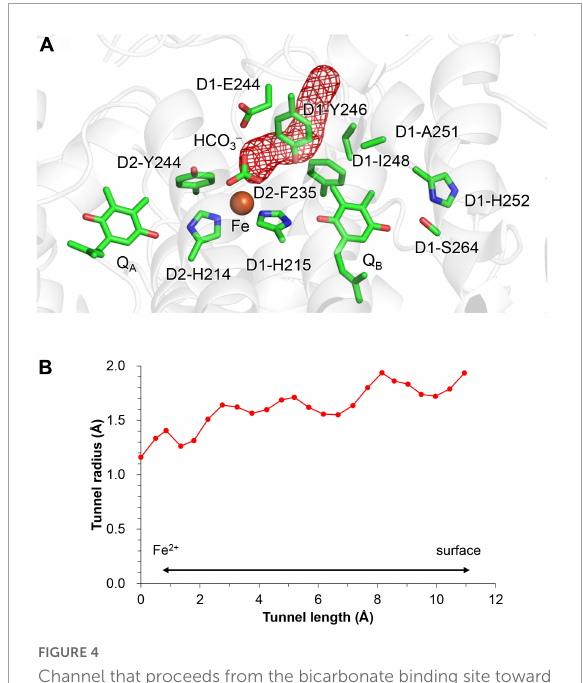
FIGURE4 Channel that proceeds from the bicarbonate binding site toward the stromal protein surface. (A) Overview of the hydrophobic channel (red mesh). (B) Cavity radius along the hydrophobic channel. The channel space was analyzed using CAVER (Chovancova et al., 2012).